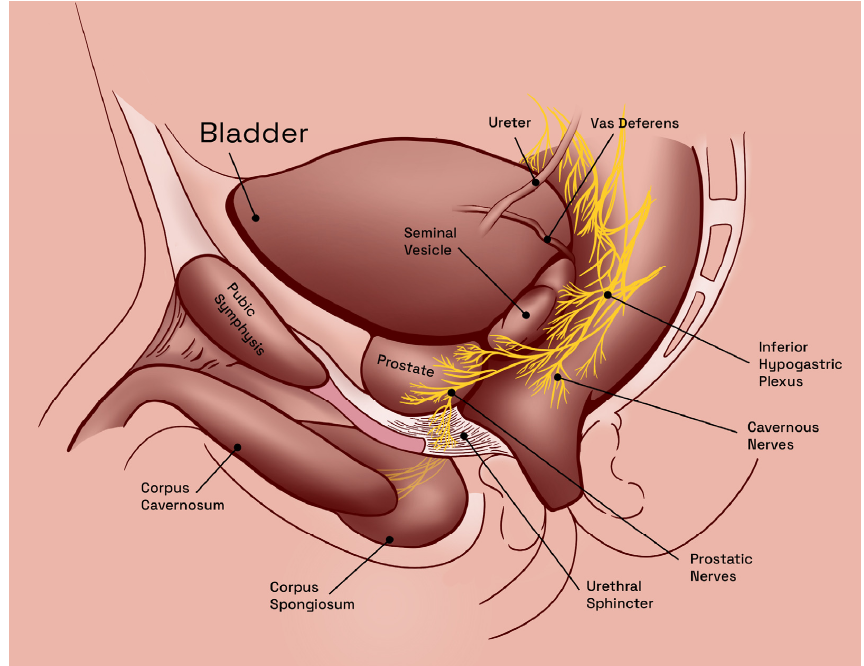
Figure 1. Anatomy of the male pelvic cavity in humans, sagittal view. Illustration adapted from Arthur L. Burnett [26]. Arthur L. Burnett